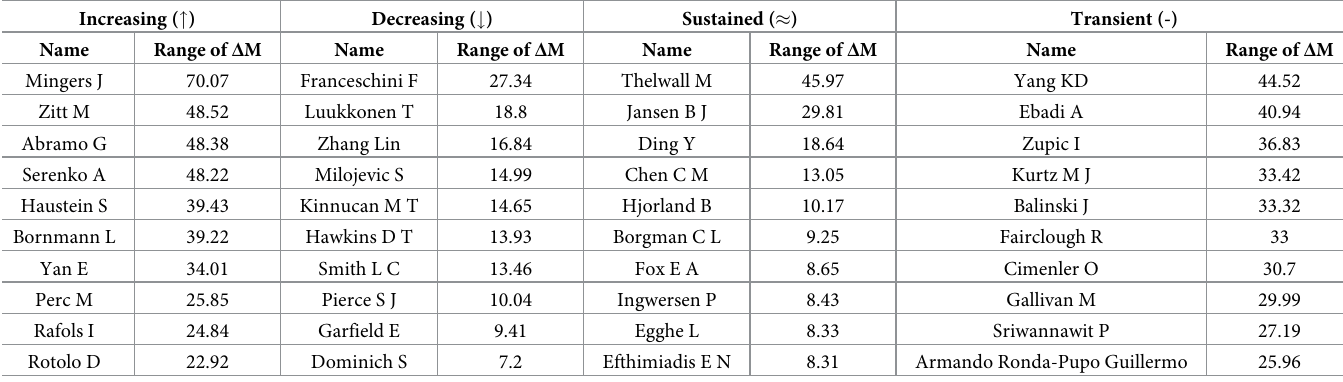
Table 3. Top 10 researchers of each of the four types and the ranges of their Δ Ms. Increasing ( "